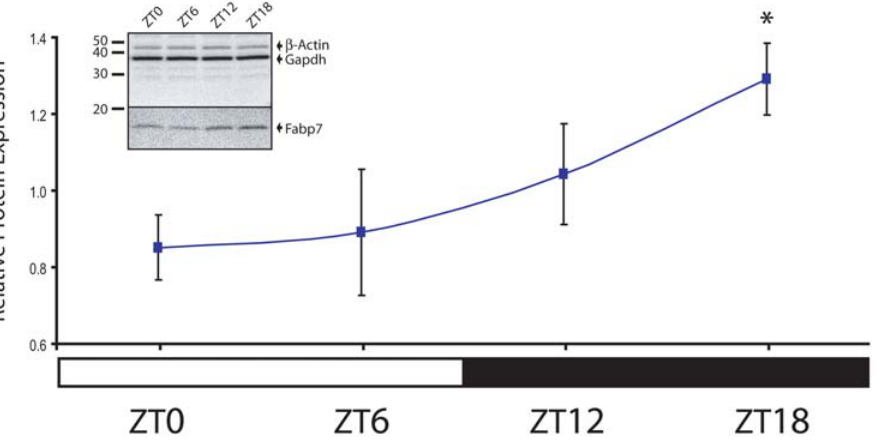
Figure 3. Fabp7 protein levels are elevated during the dark period. Graphic representation of Western blots from whole brain indicating an increase in Fabp7 protein levels with increasing Zeitgeber time. There is a significant increase in Fabp7 protein at ZT18 compared to ZT0,*p , 0.05 ( t - test). Each value represents the average + / 2 S.E.M. N =3–4 per time point. Values are normalized to an average of Gapdh and b -actin. Inset: Representative immunoblot of whole brain homogenates from tissue isolated at four diurnal time points. A single, predicted 15 kilodalton band was evident in blots incubated with anti-Fabp7 antibody. Blots were subsequently incubated with anti- b -actin and anti-glyceraldehyde-3-phosphate dehydrogenase